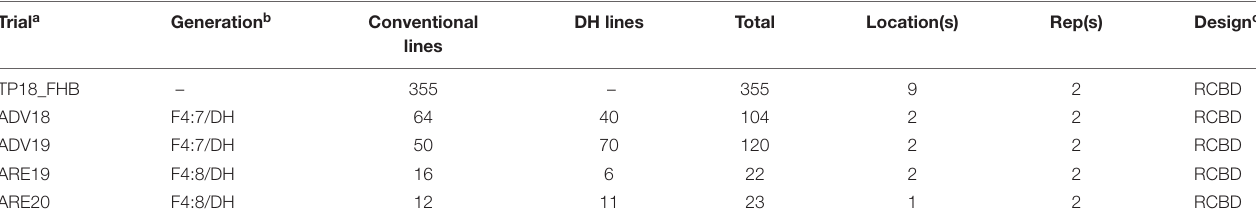
TABLE 1 | Description of the number of genotypes, composition, and experimental design of two generations of F 4 : 7 advanced nurseries (ADV), and F 4 : 8 elite nurseries (ARE), as well as the initial training population (TP18_FHB) used to predict three Fusarium head blight (FHB) resistance traits, including deoxynivalenol (DON) accumulation, Fusarium damaged kernels (FDK), and severity